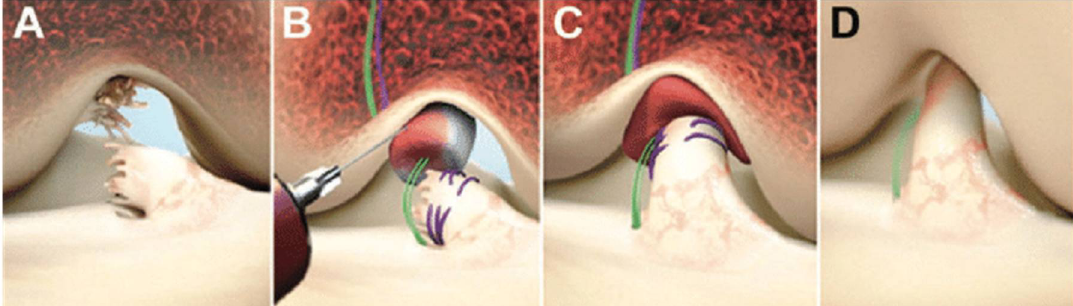
Figure 4. Bridge-enhanced anterior cruciate ligament (ACL) repair, frontal view right knee: ( A ) Ruptured ACL; ( B ) The scaffold is saturated with the patient’s blood; ( C ) The tibial stump is pulled up into the saturated scaffold; ( D ) Healing of the ACL [40].